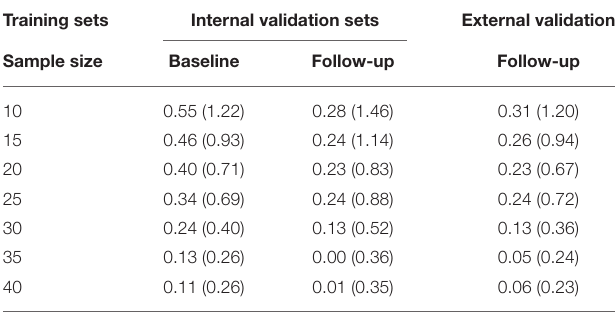
TABLE 4 | Descriptive statistics of the mean absolute errors of lesion volume [Brain Intensity AbNormality Classification Algorithm (BIANCA) predicted white matter hyperintensities (WMH)-manual mask lesion, in ml] per model and validation set at a white matter hyperintensity probability threshold of 0.8.